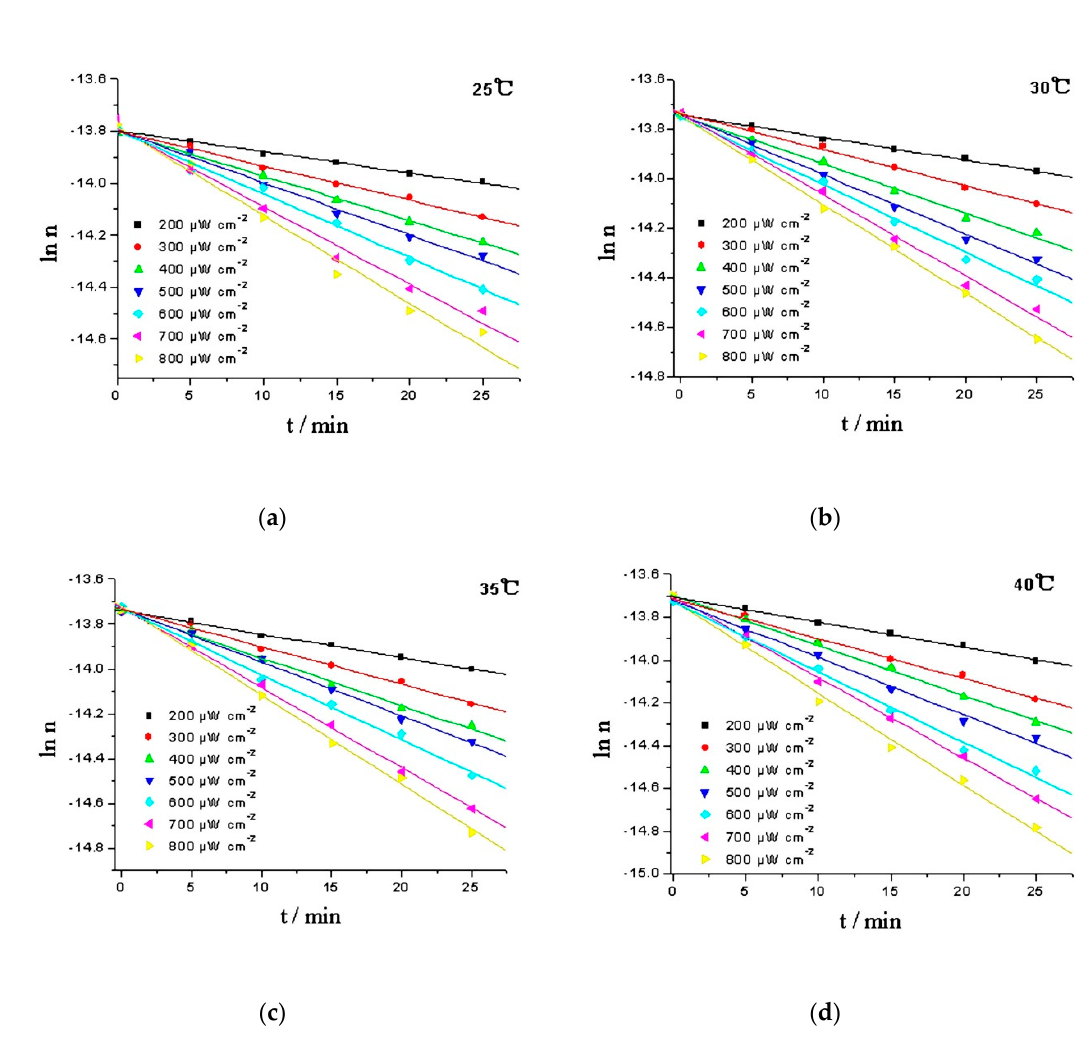
Figure 5. Comparison of the experimental (data point) and calculated values (line) of RPE photo-oxidation at various temperatures. ( a ) 25 °C; ( b ) 30 °C; ( c ) 35 °C; ( d ) 40 °C. Table 1. Kinetic parameters for the photo-oxidation of RPE.